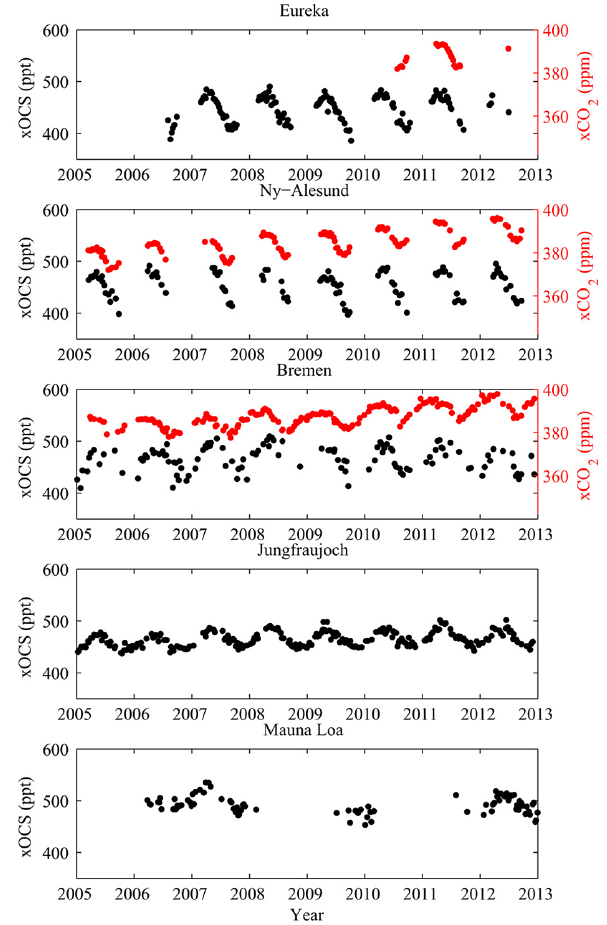
Figure 1. Weekly mean xOCS (black dots) and xCO 2 (red dots) retrieved from FTIR spectra at Eureka, Ny Ålesund, Bremen, Jungfraujoch, and Mauna